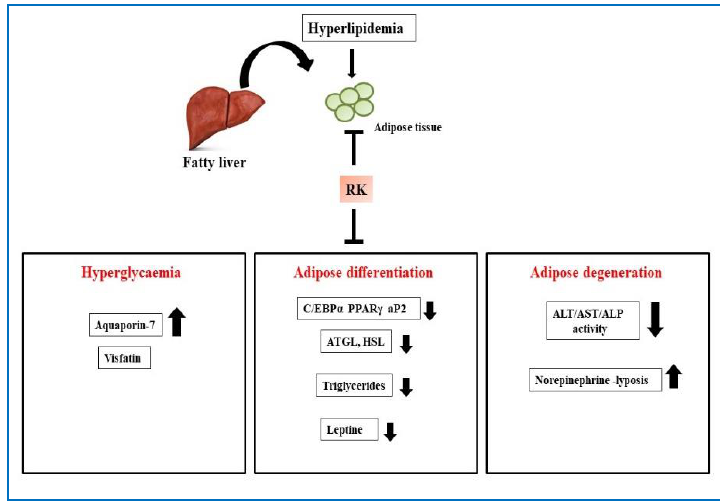
Figure 6. Schematic diagram showing the effect of RK on hyperlipidemia. Raspberry ketone-mediated adipose degeneration in the liver acts by decreasing the activities of alanine aminotransferase (ALT), aspartate aminotransferase (AST), and al- kaline phosphatase in a model control group rat serum. Raspberry ketone also reduced fat deposition in liver cells by promoting cytostasis to decrease the necrosis of liver cells [22]. In a recent study, aquaporin-7 (AQP7) was identified as an adipocyte-specific glyc- homeostasis. To identify the potential of RK in controlling body weight gain, hyper-